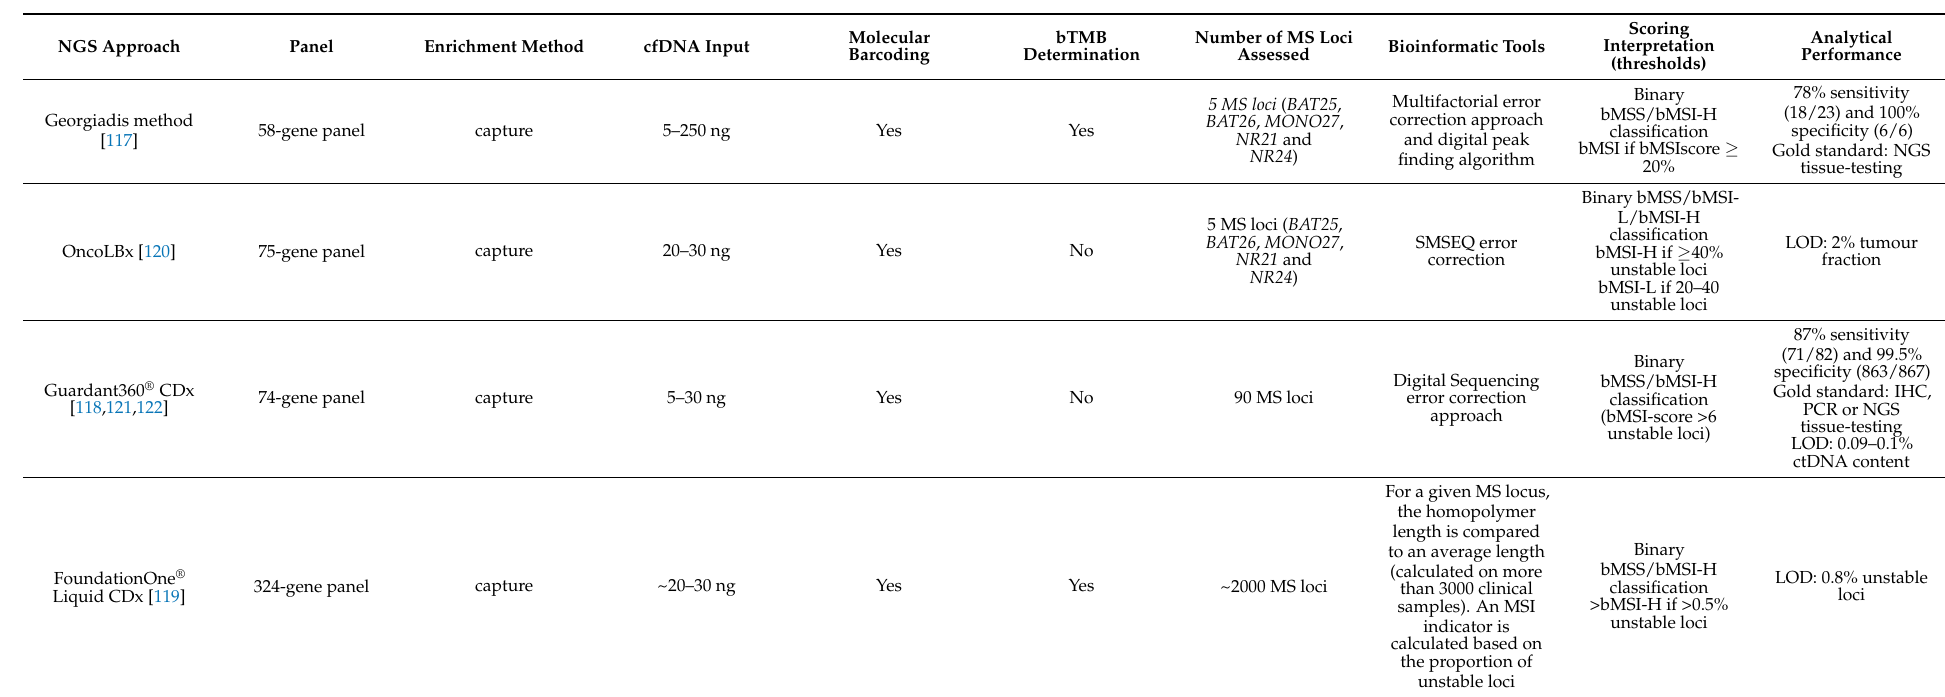
Table 4. Examples of integrated cfDNA-based pan-cancer NGS approaches for bMSI